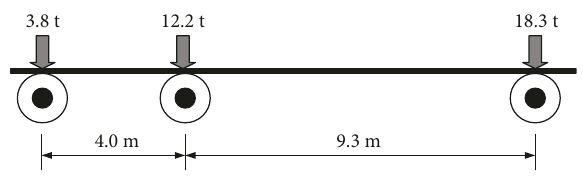
Figure 12: Suggested simplified fatigue truck model.